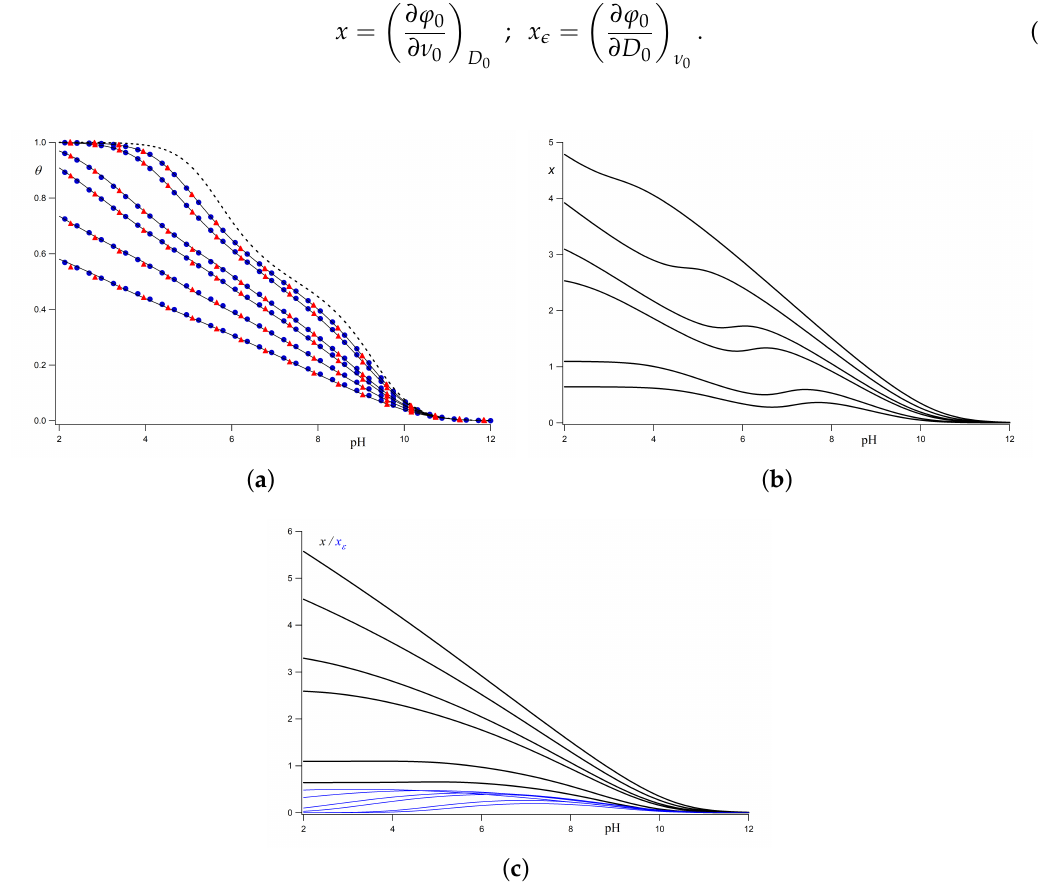
Figure 2. ( a ) Titration curves corresponding to a rigid linear chain with interacting ionizable sites separated by a distance b = 0.2 nm obtained using Monte Carlo (MC) simulations (blue circles), Local Effective Interaction Parameters (LEIP) method correcting only the p K -value (continuous line) and LEIP method correcting the p K -value and the the nearest neighbour interaction energy (cid:101) (red triangles). The chosen parameters are p K = 9 and (cid:101) = 1.5. The Long-Range (LR) interactions are calculated using the Debye–Hückel potential. The dashed line represents the titration curve in the absence of LR interactions. Note that the correction to the p K -value is enough to reproduce almost exactly the MC simulations and no significant improvement is obtained in correcting (cid:101) ; ( b ) correction x to the p K -value using the LEIP method; ( c ) corrections x (black lines) and x (cid:101) (blue lines) to the p K -value and the nearest neighbour interaction energy (cid:101) , respectively. In all the figures, from top to bottom, the ionic strengths are 1 M, 0.5 M, 0.1 M, 0.05M, 0.01 M and 0.001